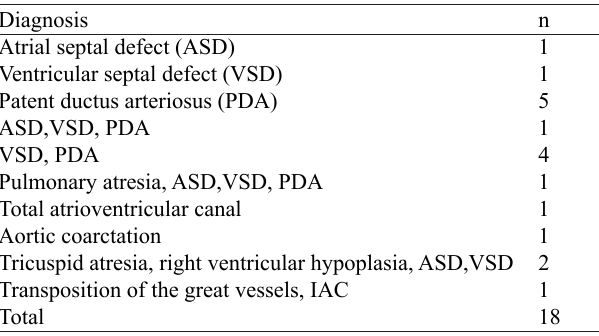
Table 1. Diagnosis of congenital heart